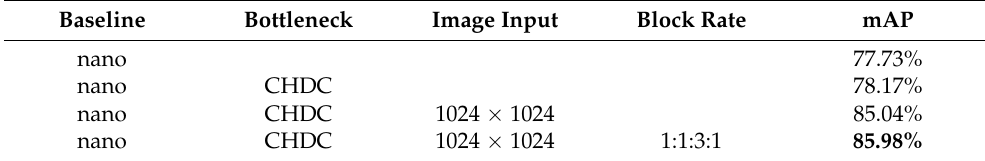
Table 6. Ablation experiments for ECSP as the backbone.